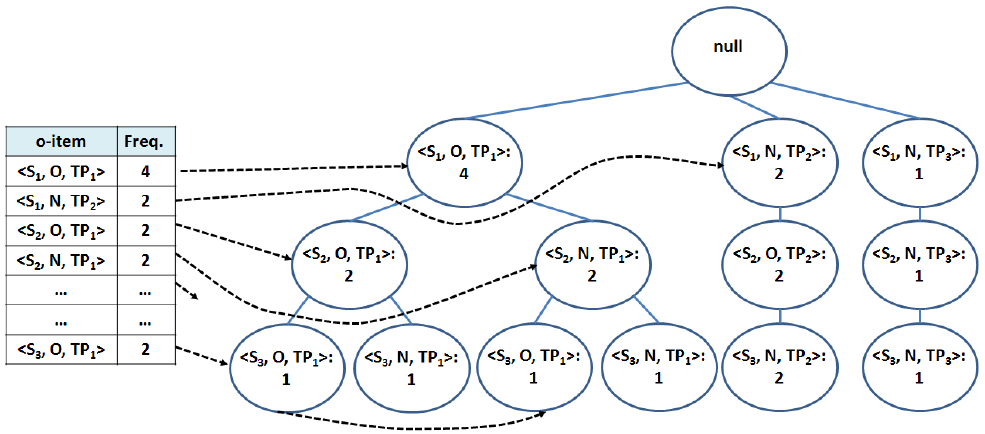
Figure 2. The FP-tree representing the example transactional occupancy level dataset (Table